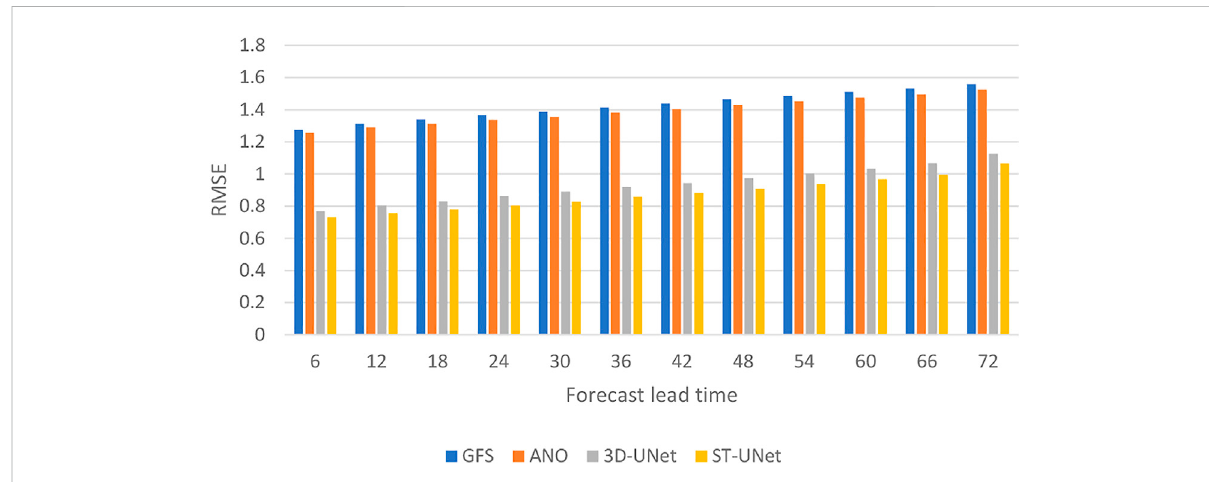
FIGURE 8 The RMSE of bias correction on the 10-m u component of wind for different forecast times on the test set.